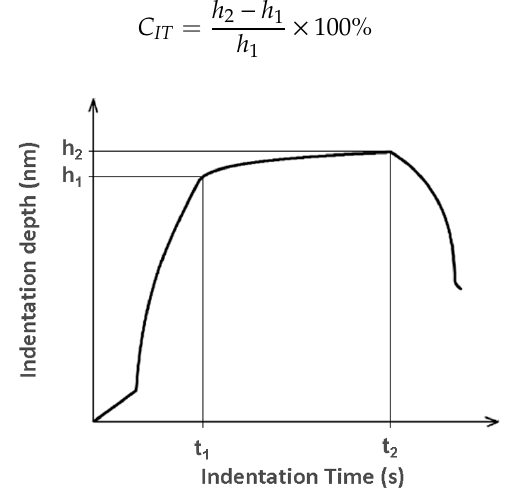
Figure 4. Displacement–time curve showing the indentation creep.